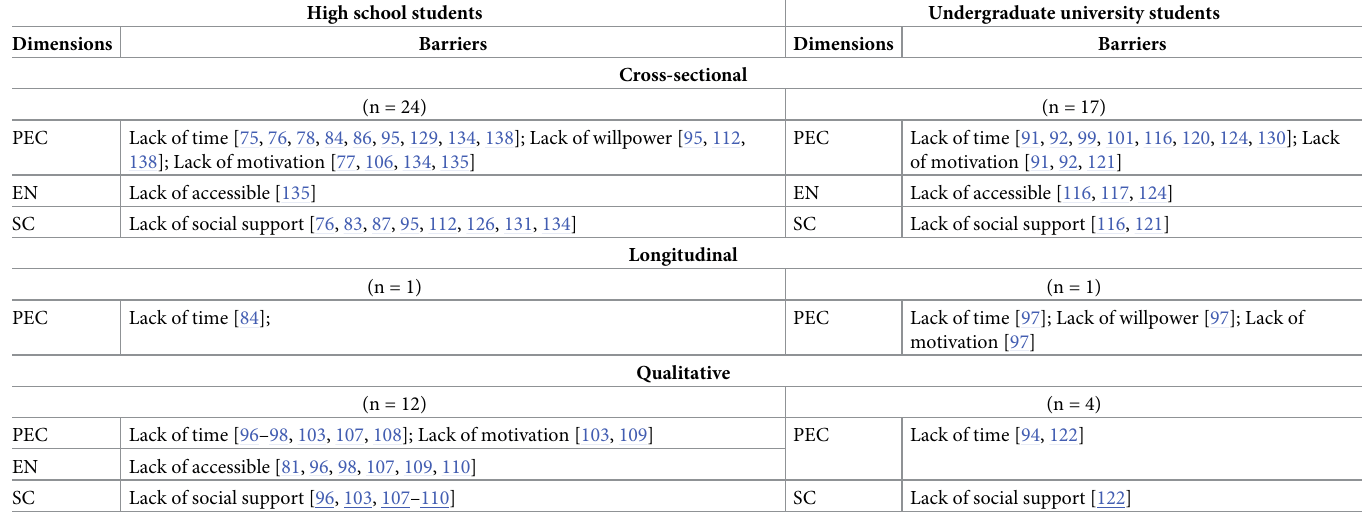
Table 4. Main barriers for each dimension grouped by the study